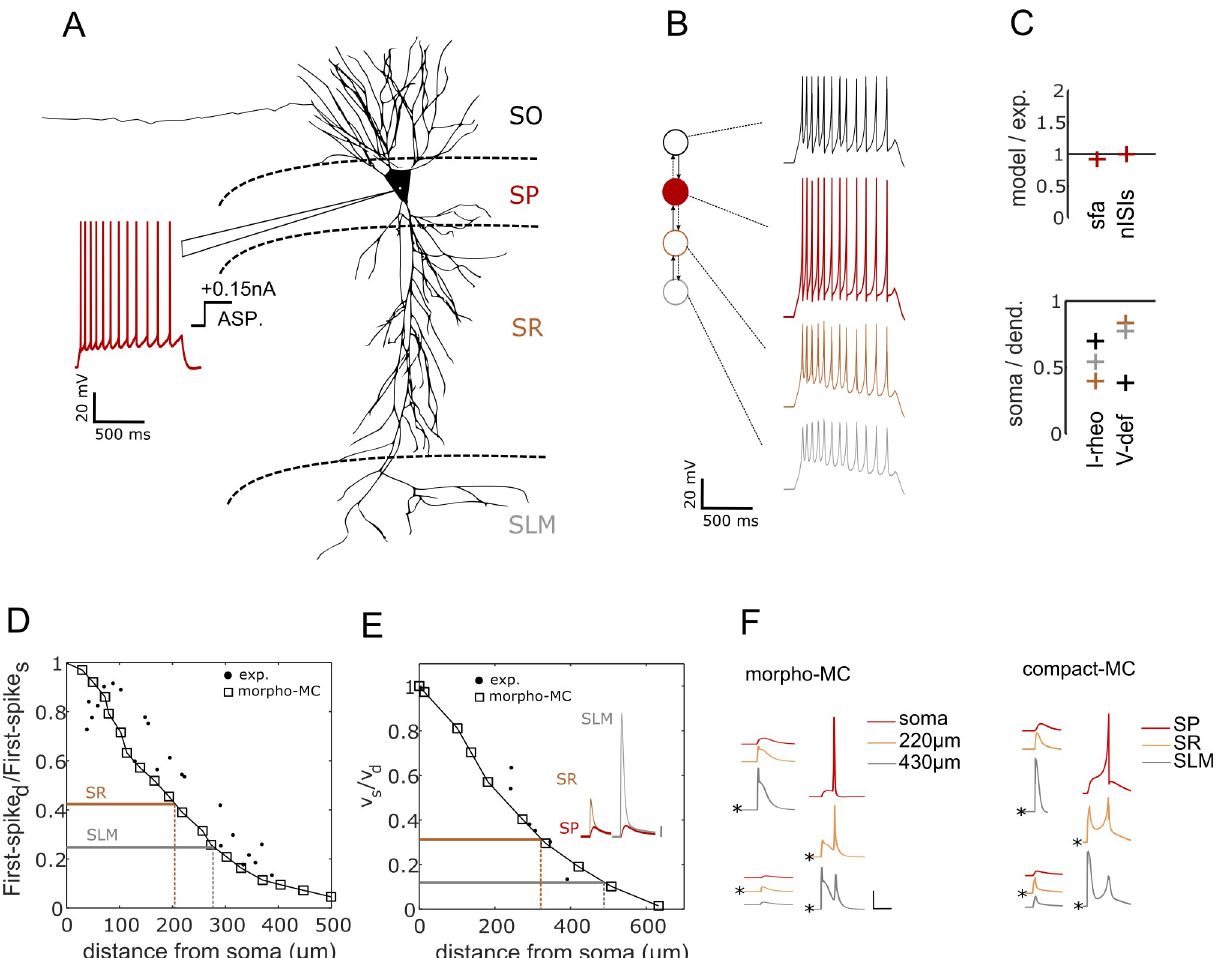
Fig 5. A 4-compartment model of CA1 Pyramidal neuron. ( A ) A whole-cell patch clamp recording from a CA1 Pyramidal neuron [44] digitized by Hippocampome.org , and digitally reconstructed morphology of the same type [45] reproduced from NeuroMorpho.Org [26]. ( B ) Layout of the compartments (left) and their responses to somatic input current of +0.15 nA . ( C ) Somatic compartment reproduces key features that are quantitatively comparable to the experimental features (top). Minimum depolarizing input required to elicit a spike (I-rheo) and steady-state voltage deflection (V-def) for a hyperpolarizing input are higher in dendritic compartments than the somatic compartment (bottom). ( D ) Attenuation of first back-propagating spike from experimental recordings (exp.), in morphologically detailed multi-compartment model (morpho-MC) and in compact-MC model (horizontal lines; for the spike trains in B). First-spike d and First-spike s denote amplitudes of first spikes at dendrite and soma, respectively. Vertical lines indicate the distances of the morpho-MC sections from the soma that correspond to the attenuation profiles of proximal (SR) and distal (SLM) compartments in the IM. ( E ) Attenuation of dendritic EPSPs as they propagate towards the soma. V s and V d are amplitudes of EPSPs at soma and dendrite, respectively. Inset shows compartment responses for a single synaptic stimulation at SR (left) and SLM (right). Calibration: 0.2mV. ( F ) Conditional spike propagation in morpho-MC (left) and compact-MC (right) models of a CA1 Pyramidal neuron. ‘ � ’ denote the stimulated compartment. A single spike initiated at the distal compartment (top left traces: stimulation at 430 μ m in SLM) failed to propagate to the soma. Additional depolarization level at the proximal compartment (bottom left traces: stimulation at 220 μ m in SR) facilitates propagation of spike initiated at the distal compartment (right traces) to the soma in both models. Experimental data digitized from [46] (D) and [47](E). Multi-compartment CA1 Pyramidal model from [20] was used to obtain morpho-MC data. Calibration: 20mV, 20ms. CA1 Pyramidal neurons exhibit strong attenuation of spike amplitudes as they propagate from the soma to apical dendrites [46,48]. This attenuation has been attributed to the highly dense expression of transient A-type K + conductance in the dendrites [48,49]. We compared the attenuation of back-propagating spikes between compact-MC and morpho-MC models (Figs 5D and S3A). The compartments SR and SLM in the compact-MC model matched the attenuation profiles of morpho-MC sections at ~210 μ m and ~275 μ m, respectively, from the